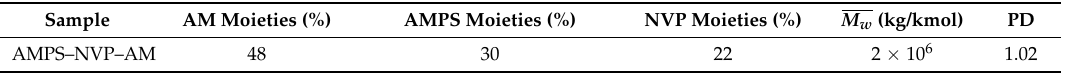
Table 2. Chemical composition, molecular weight, and polydispersion of the polymer sample. Sample AM Moieties (%) AMPS Moieties (%) NVP Moieties (%) M w (kg/kmol)